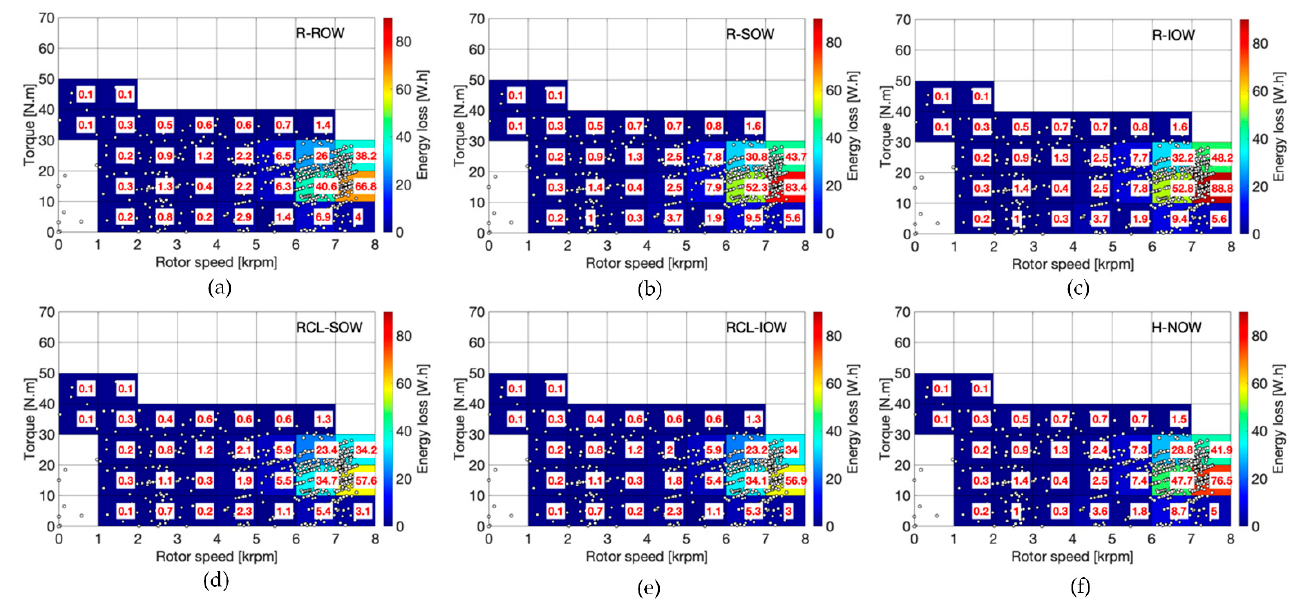
Figure 13. Energy loss distributions of the IPMSM with ( a ) R-ROW, ( b ) R-SOW, ( c ) R-IOW, ( d ) RCL-SOW, ( e ) RCL-IOW, and ( f ) H-NOW arrangements, along the ARTEMIS motorway driving cycle.